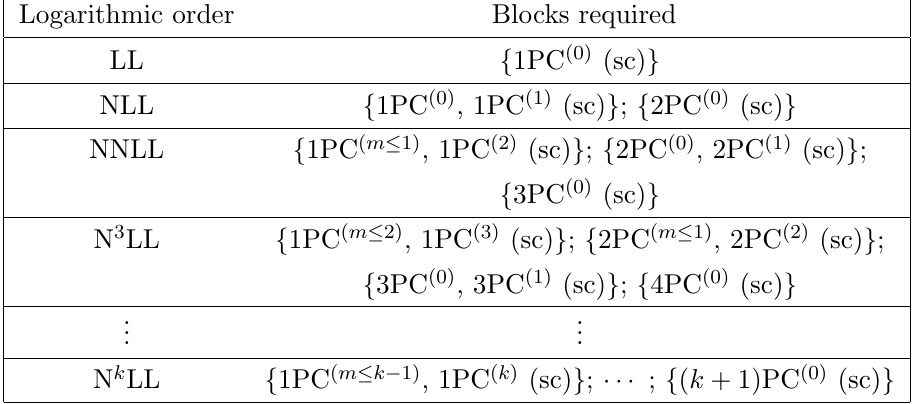
Table 1 . Blocks to be included in the squared-amplitude decomposition at a given logarithmic order. At each order, the higher-rank blocks are to be included in the soft-collinear limit (\sc" in the